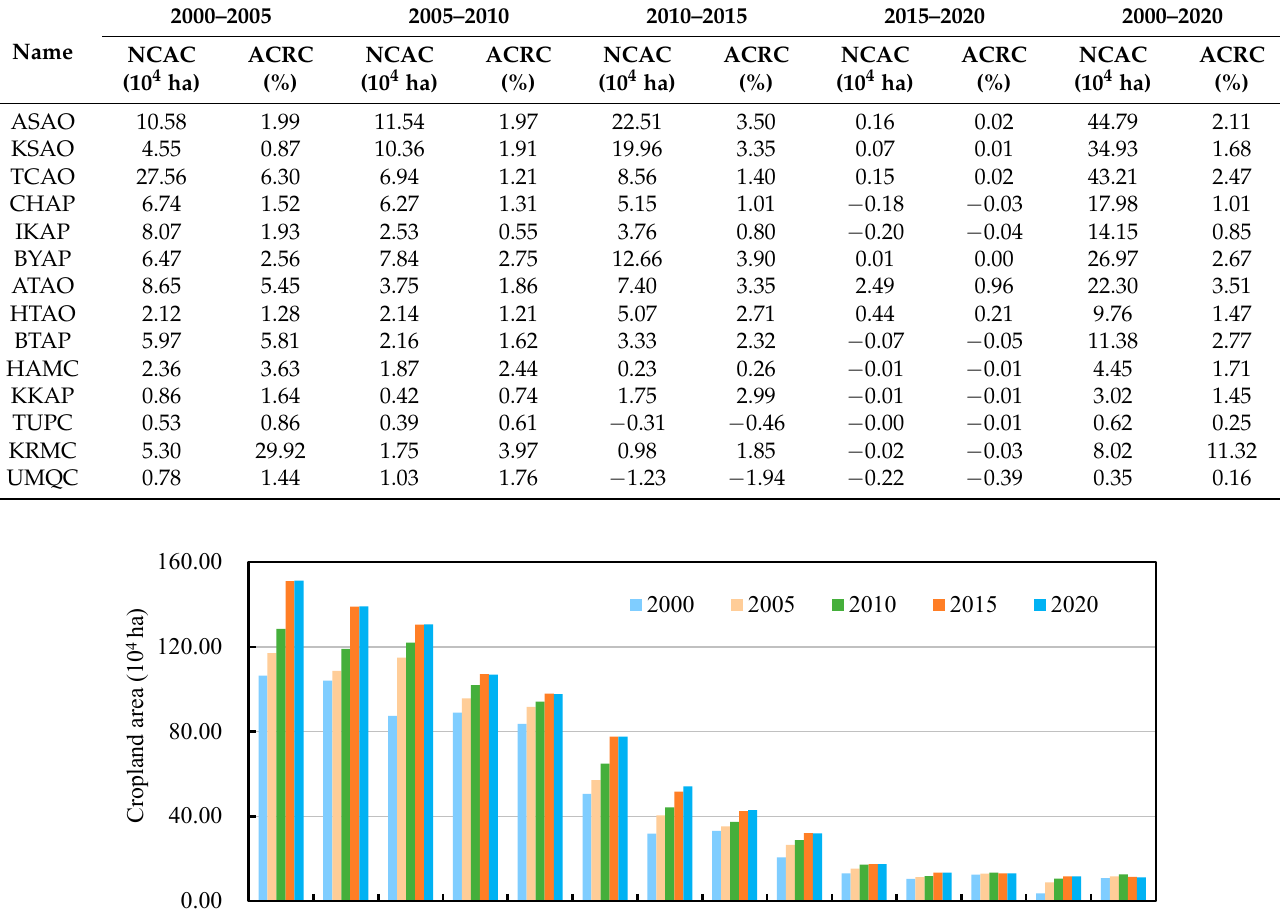
Table 5. Differences in the NCAC and ACRC in different prefectures of Xinjiang during 2000–2020.